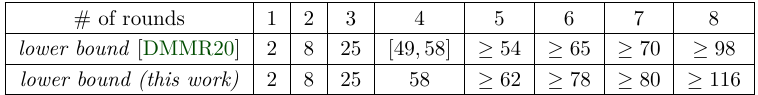
Table 1: Lower bounds on the weight of differential trails in Subterranean . # of